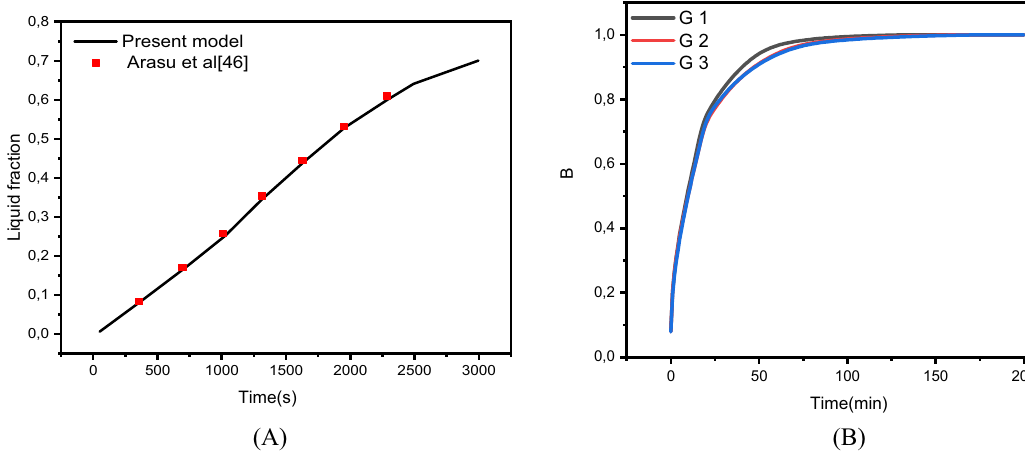
Figure 3. ( A ) Comparison of numerical results with 46 . ( B ) Grid independent study.